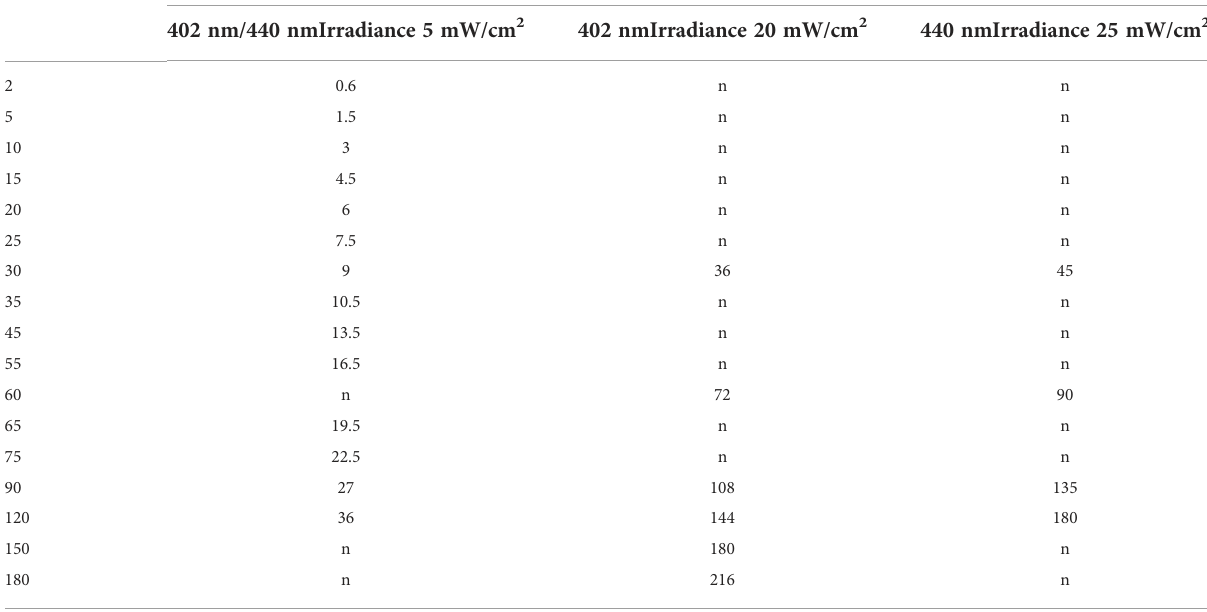
TABLE 1 Irradiation doses used in